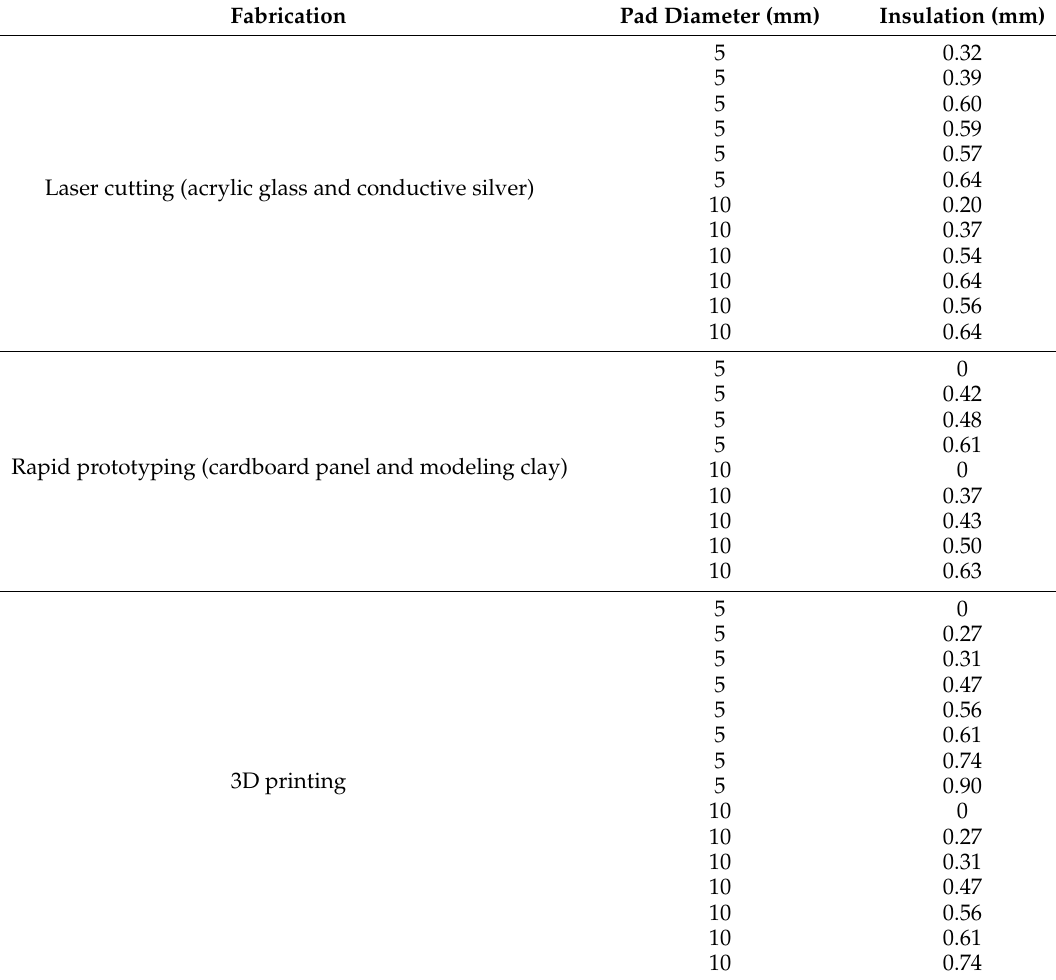
Table 4. Measured thickness of insulating layer for each marker type. An insulation layer of 0 mm indicates that there is no insulation layer and that the conductive pads are directly on the touch screen display. The values for Laser cutting and rapid prototyping are listed on the left side, the ones for 3D printing on the right. Fabrication Pad Diameter (mm) Insulation (mm)